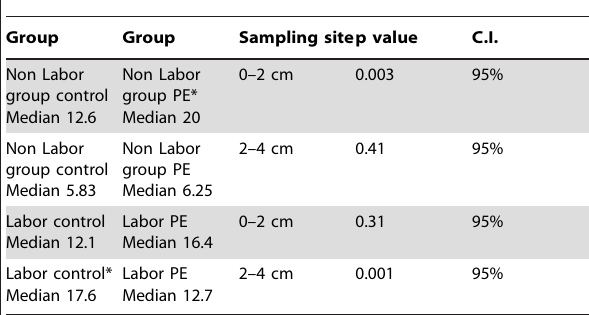
The representative blot is shown in Figure 6.